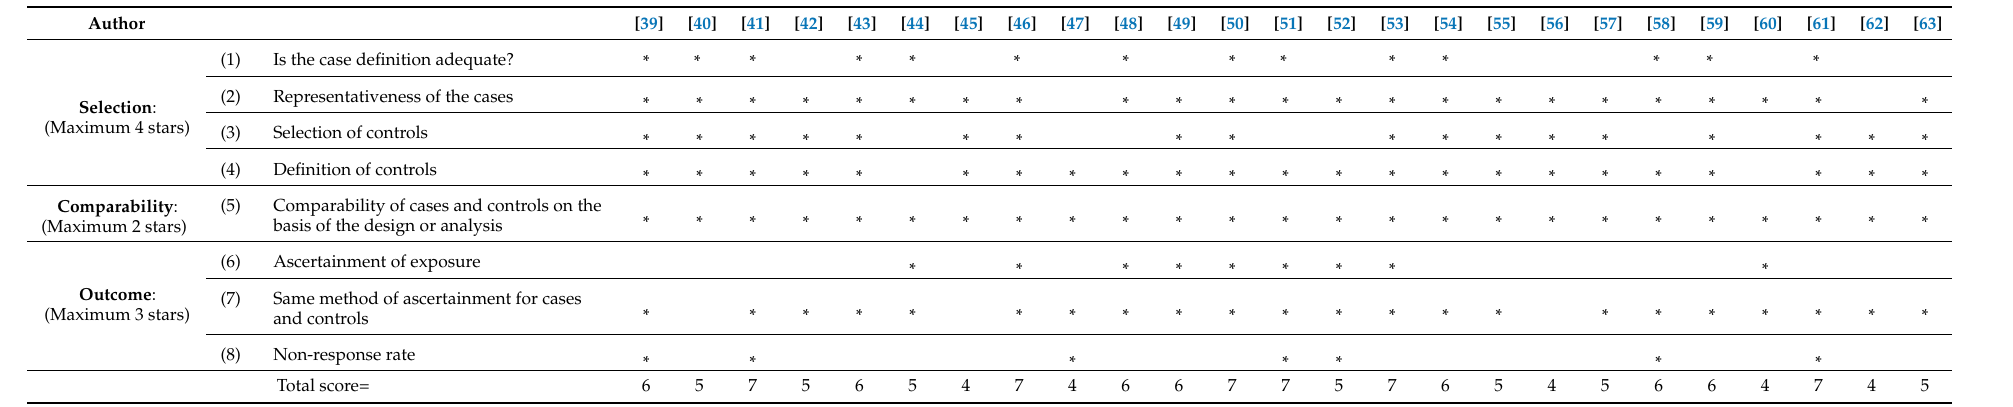
Table 2. Newcastle–Ottawa quality assessment scale: case–control